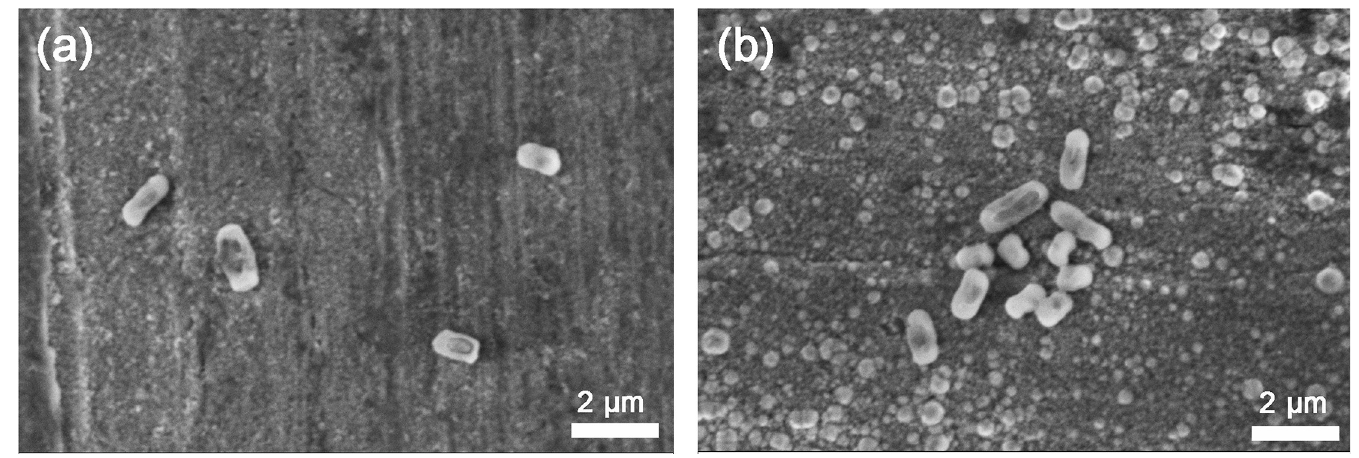
Fig 10. SEM images of surface morphologies and presence of bacteria adherent to the surface of one-day tarnished/corroded Cu metal without (a) and with (b) ASW deposition followed by exposure for 24 h to E. Coli (OD 600 = 0.5) and the concomitant detachment of looosly adherent bacteria via vigorous vortexing (1 min) in ASW.